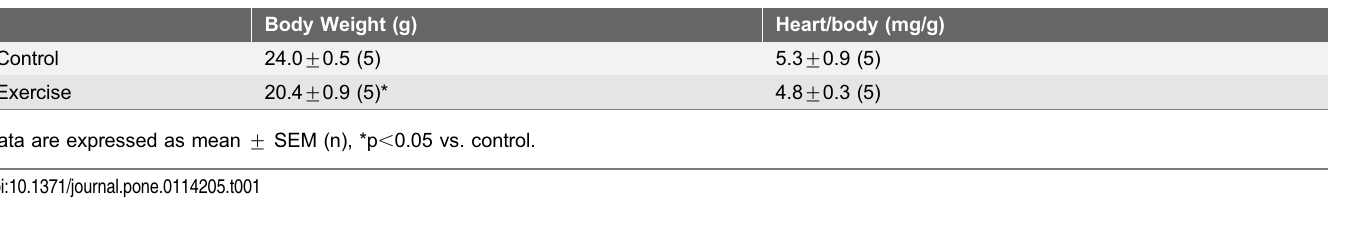
Table 1. The effect of 8-week endurance exercise on heart and body weight.